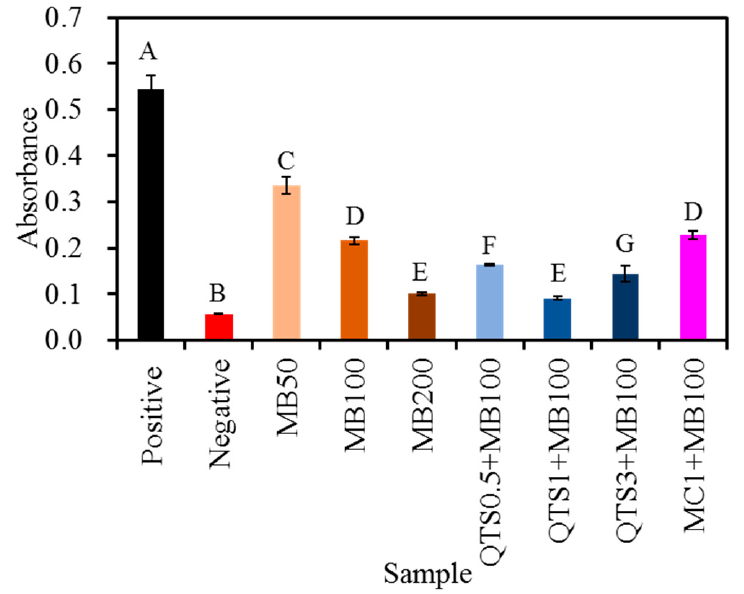
Figure 7. Residual lipopolysaccharide (LPS) level derived from A. actinomycetcmcomitans on sample surfaces after various photoantimicrobial chemotherapy (PACT) treatments. The contaminated Ti alloy without PACT and the sterile Ti alloy were used as a positive control and negative control, respectively. Different capital letters showed statistically significant differences at p < 0.05 ( n = 5).